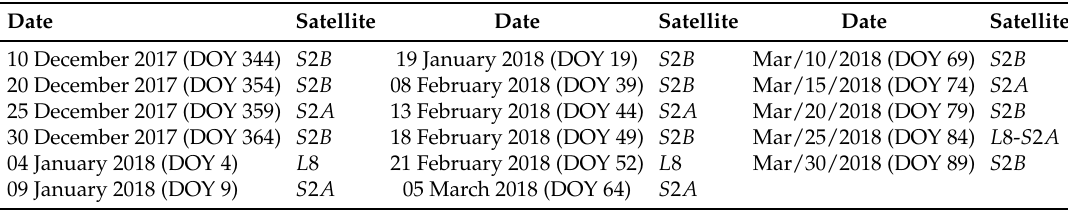
Table 2. L 8 and S 2 satellite image dates (DOY: Day Of Year).